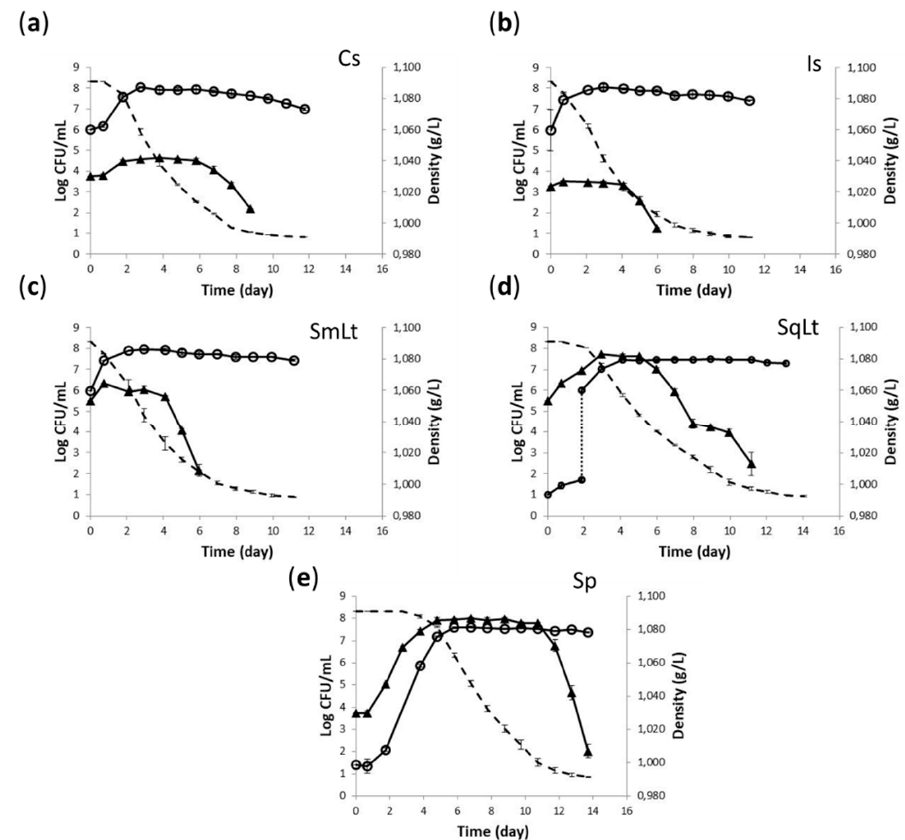
Figure 2. Yeast dynamics (continuous line) of non-sterile must with: ( a ) Cs—commercial S. cerevisiae ; ( b ) Is—indigenous S. cerevisiae PzV6; ( c ) SmLt— L. thermotolerans P-HO1 and S. cerevisiae PzV6 added simultaneously; ( d ) SqLt— L. thermotolerans P-HO1 and S. cerevisiae PzV6 added sequentially; and ( e ) Sp—native microbiota. Ethanol sulfite agar was used for enumeration of S. cerevisiae ( ○ ), and Lysine agar for non- Saccharomyces yeasts ( ▲ ). Dashed line indicates the density drop during the fermentation